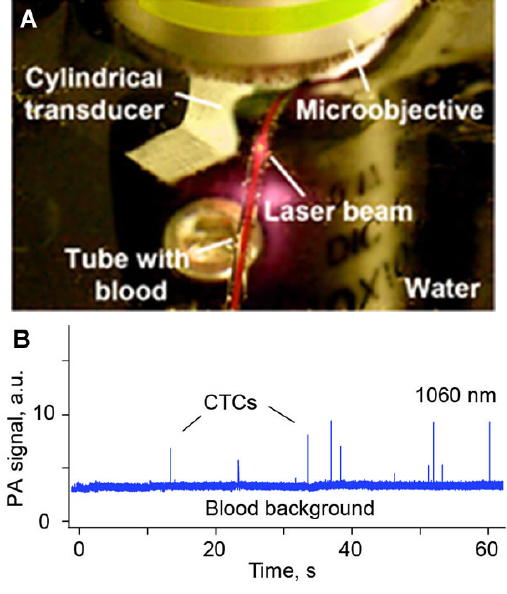
Figure 28. ( A ) In vitro PAFC with focused cylindrical transducer; ( B ) Typical PA signal trace from rare melanoma cells (B16F01) in 0.8 mm flow tube with mouse blood extracted from tumor-bearing mouse model [82]. Laser parameters: wavelength, 1,064 nm; pulse width 10 ns; pulse rate, 10 kHz; pulse energy, up 50 µJ; linear beam size, 5 µm × 1 mm